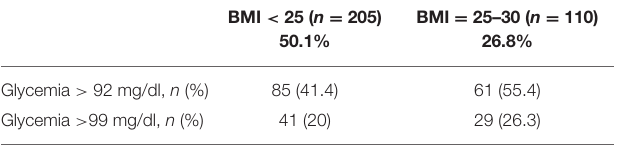
TABLE 2 | Clinical features in terms of pregestational BMI and fasting glycemia in pregnancy of the entire population of pregnant diabetes women with negative GAD antibodies.